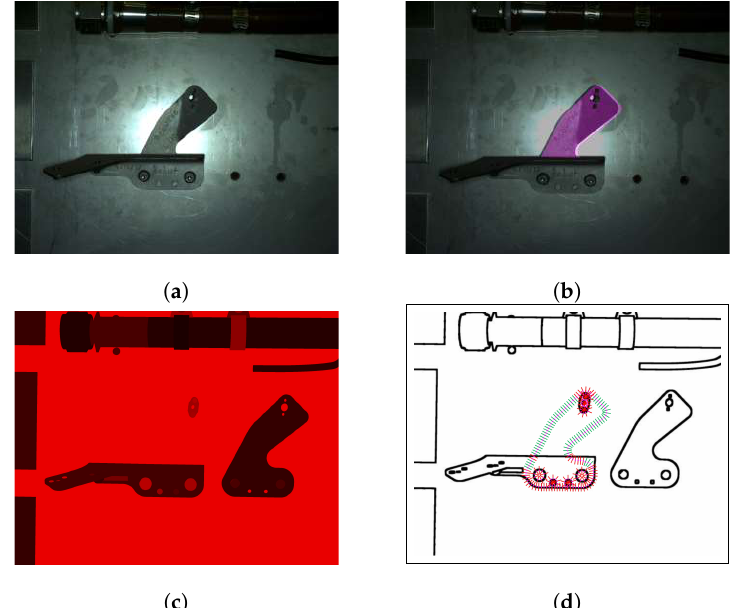
Figure 11. Illustration of the parasitic edges handling: ( a ) input image, ( b ) projection of the element to be inspected, ( c ) context image of the element to be inspected and its projected edgelets, and ( d ) gradient changes in the context image and considered edgelets (green) and rejected edgelets (red).